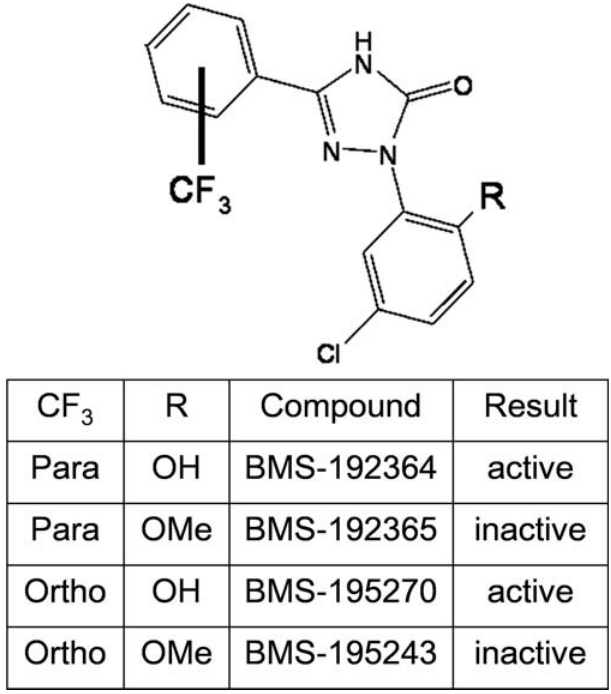
Figure 1. Structure and Activity of BMS Small Molecules The effect of each compound on inhibition of carbachol-evoked tonicity of isolated rat bladder strips is shown in the table. DOI: